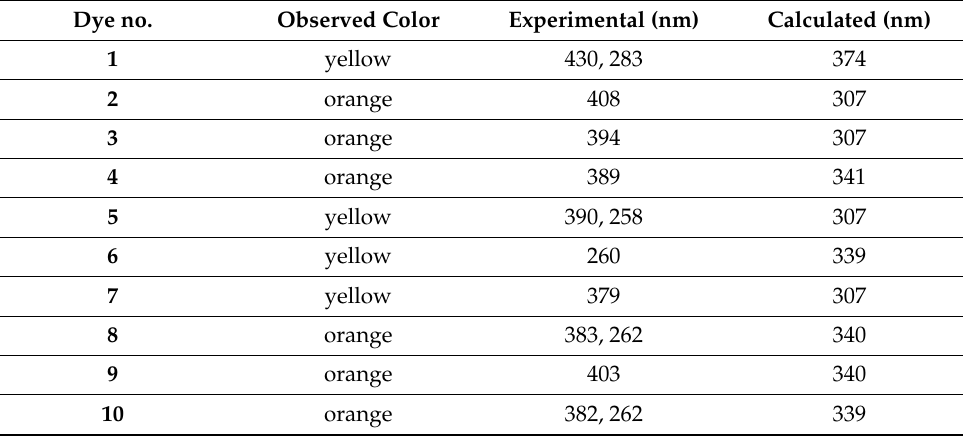
Table 2. Experimental and calculated absorption maxima of the azo dyes 1 – 10 in CHCl 3 . Dye no. Observed Color Experimental